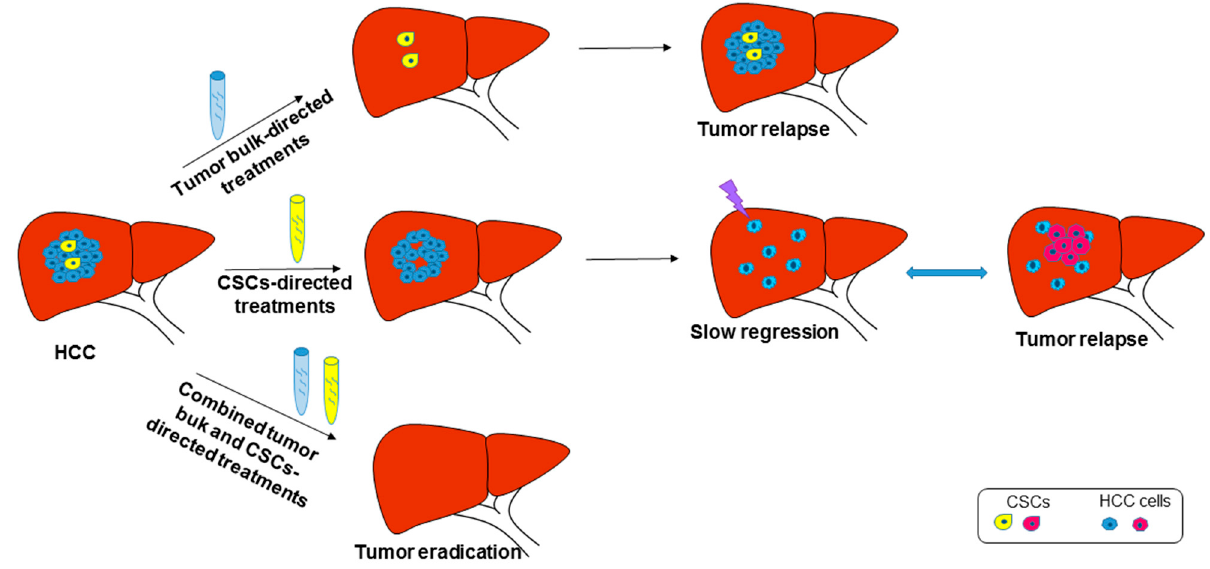
Figure 2. Tumor bulk and CSC-based combined treatments of HCC. Top panel: tumor bulk-directed treatments might lead to tumor relapse due to CSC reactivation. Central panel: CSC-directed treatments might lead to tumor relapse due to the acquisition of further DNA mutations and the possible transdifferentiation of tumor cells. Bottom panel: increased efficacy of combined treatments leading to tumor eradication.